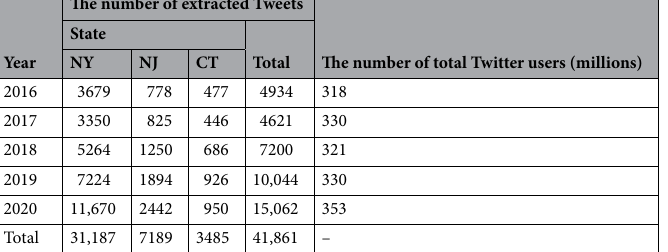
Table 1. The number of valid tweets included for data analysis for 2-month window (March 13–May 12) in each year from 2016 to 2020, and the number of total Twitter users. The data for the number of total Twitter users are from